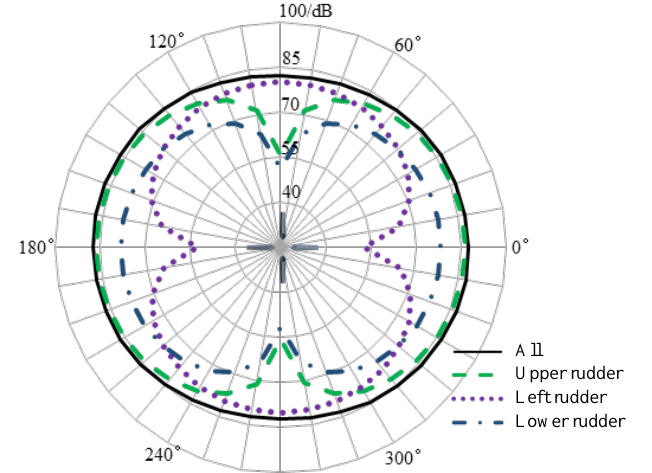
Figure 23. Directivity of sound pressure levels of each rudder surface of the cross-type tail part.